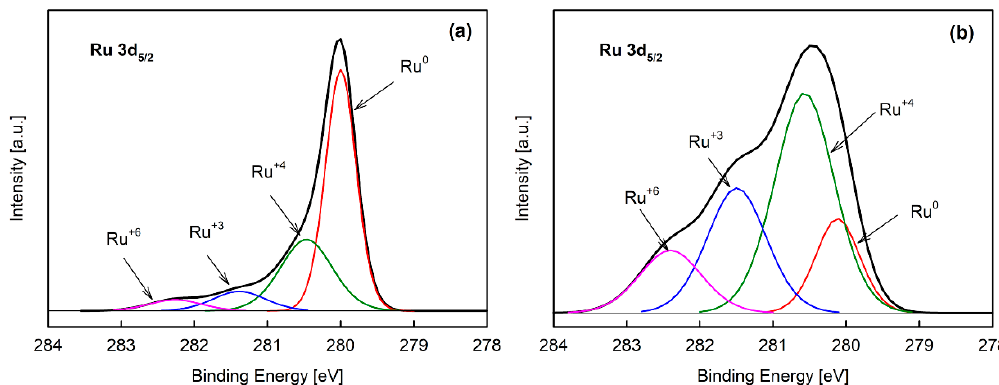
Figure 2. X-ray photoelectron spectrometry (XPS) Ru 3d 5/2 spectra of the plasma-deposited Ru-based film: ( a ) as-deposited; ( b ) after five LSV cycles.